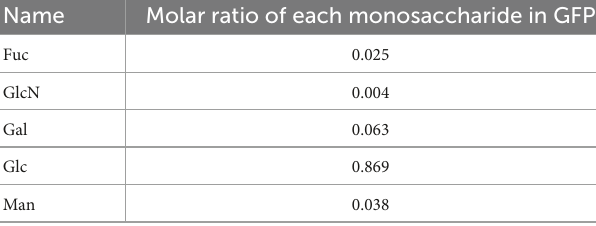
1) Statistical analysis and